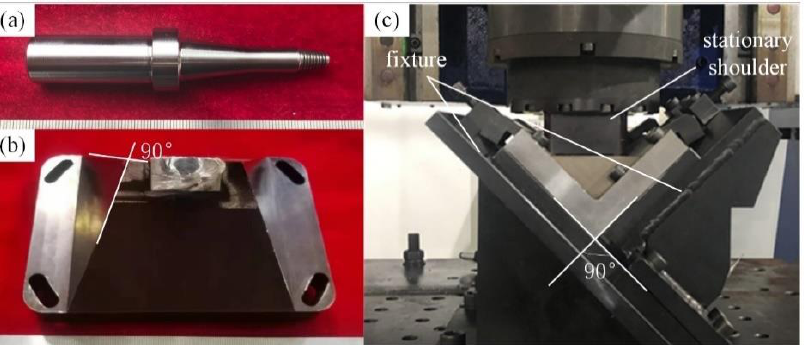
Figure 2. Physical drawing of welding platform: ( a ) SSFSW tool and ( b ) stationary shoulder and ( c ) the welding fixture employed for producing T-joint welds. Table 5. Welding parameters of the SSFSW of 2A14 Al-alloy T-joints.